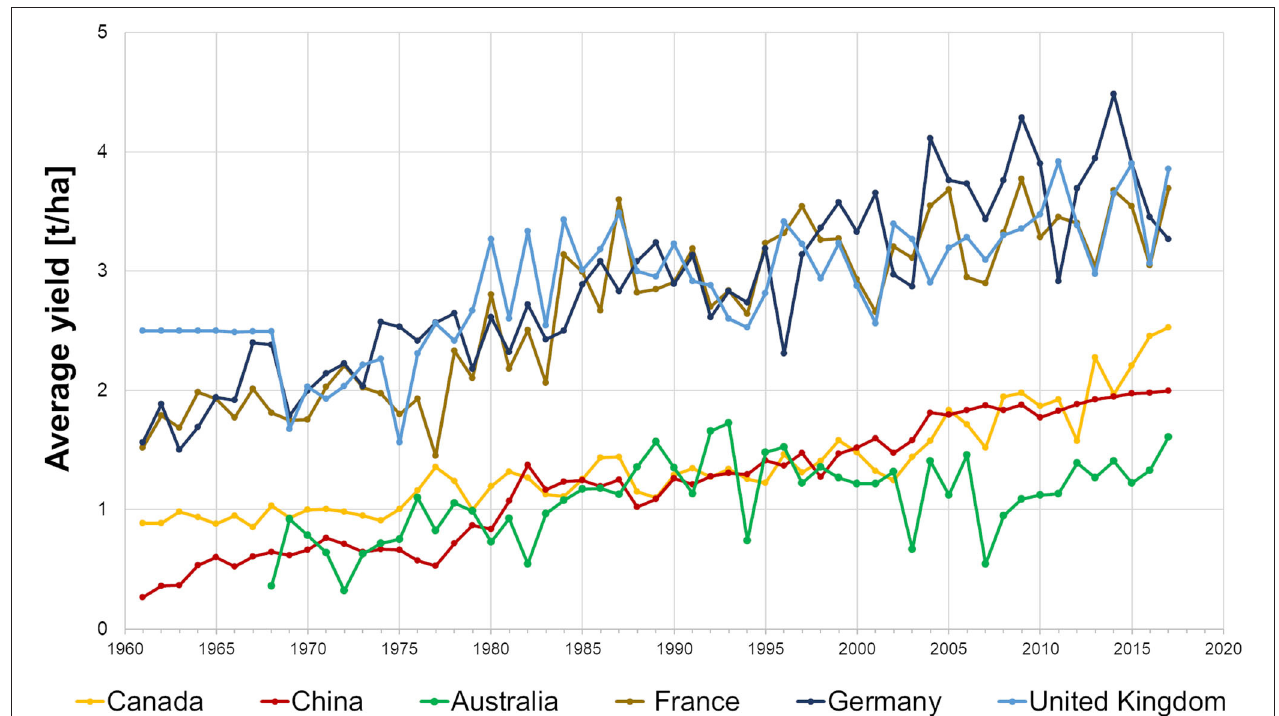
FIGURE 1 | Development of average yields of oilseed rape in main producing countries from 1961 to 2017 (FAO